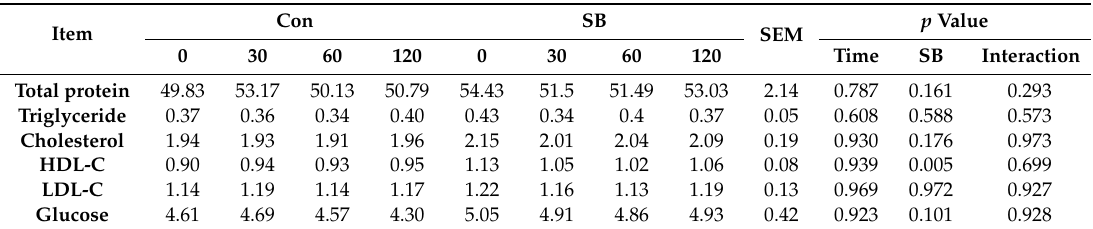
Table 1. Serum metabolite concentrations of pigs in the control (Con) and sodium butyrate (SB) groups at 0, 30, 60, 120 min after intravenous infusion ( n = 7) 1